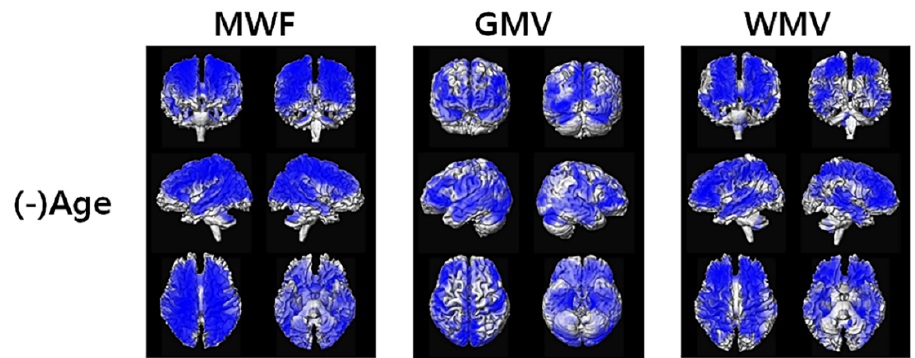
Figure 3. Results of the voxel-based multiple regression analysis between the all-participant maps of the apparent myelin water fraction (MWF), gray matter volume (GMV), and white matter volume (WMV).